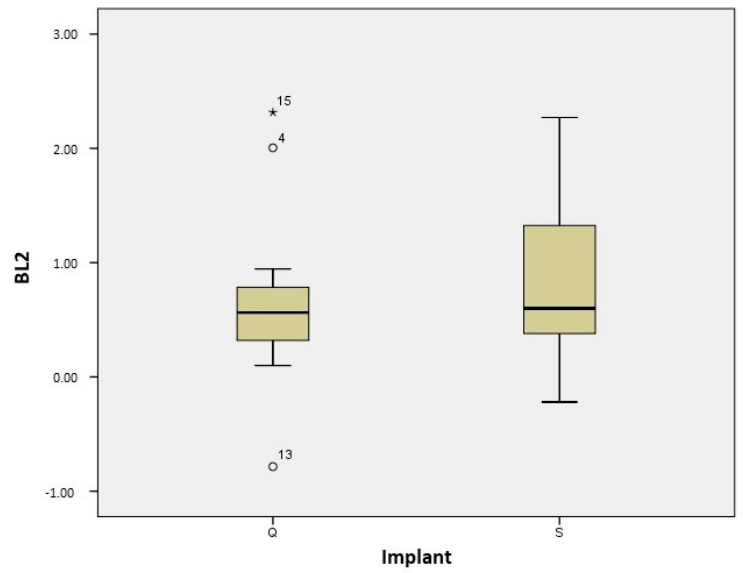
Figure 5. Box plot of bone level for both implant designs at 5 years after loading (deadline), with no statistically significant difference between them. S = Standard implant, Q = Quattro implant. O = Outliers. * = Extreme